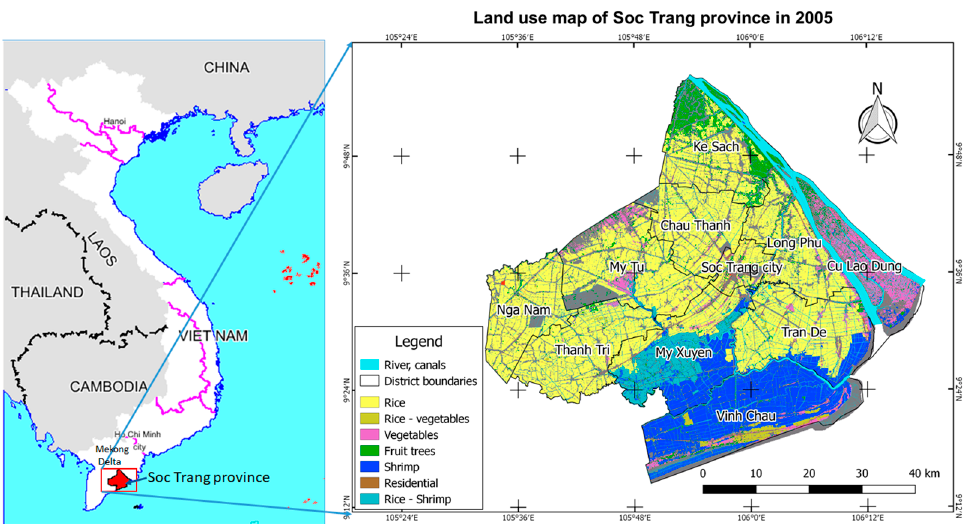
Figure 3. Case study in Soc Trang Province with a land-use map from 2005. (Source: DONRE of Soc Trang, 2005 [37])